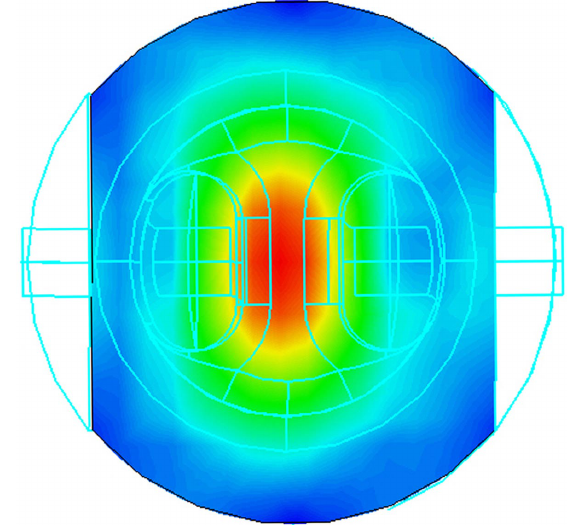
FIG. 3. (Color) Distribution of H -field, and thus the current in a conventional tuner plate of a 2-QWR operating in the accelerat- ing mode.